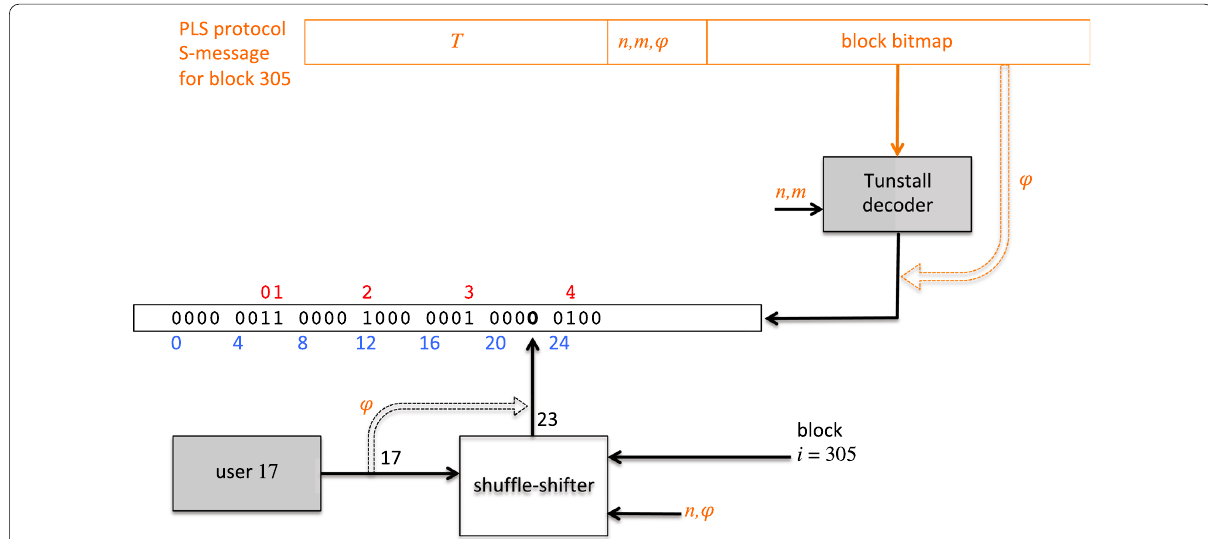
Fig. 10 Obtaining proof of absence. Solid arrows show the flow of data, dotted arrows indicate a possible bypass controlled by